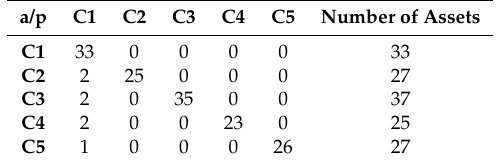
Table 4. Confusion classification matrix: vertical—actual class,